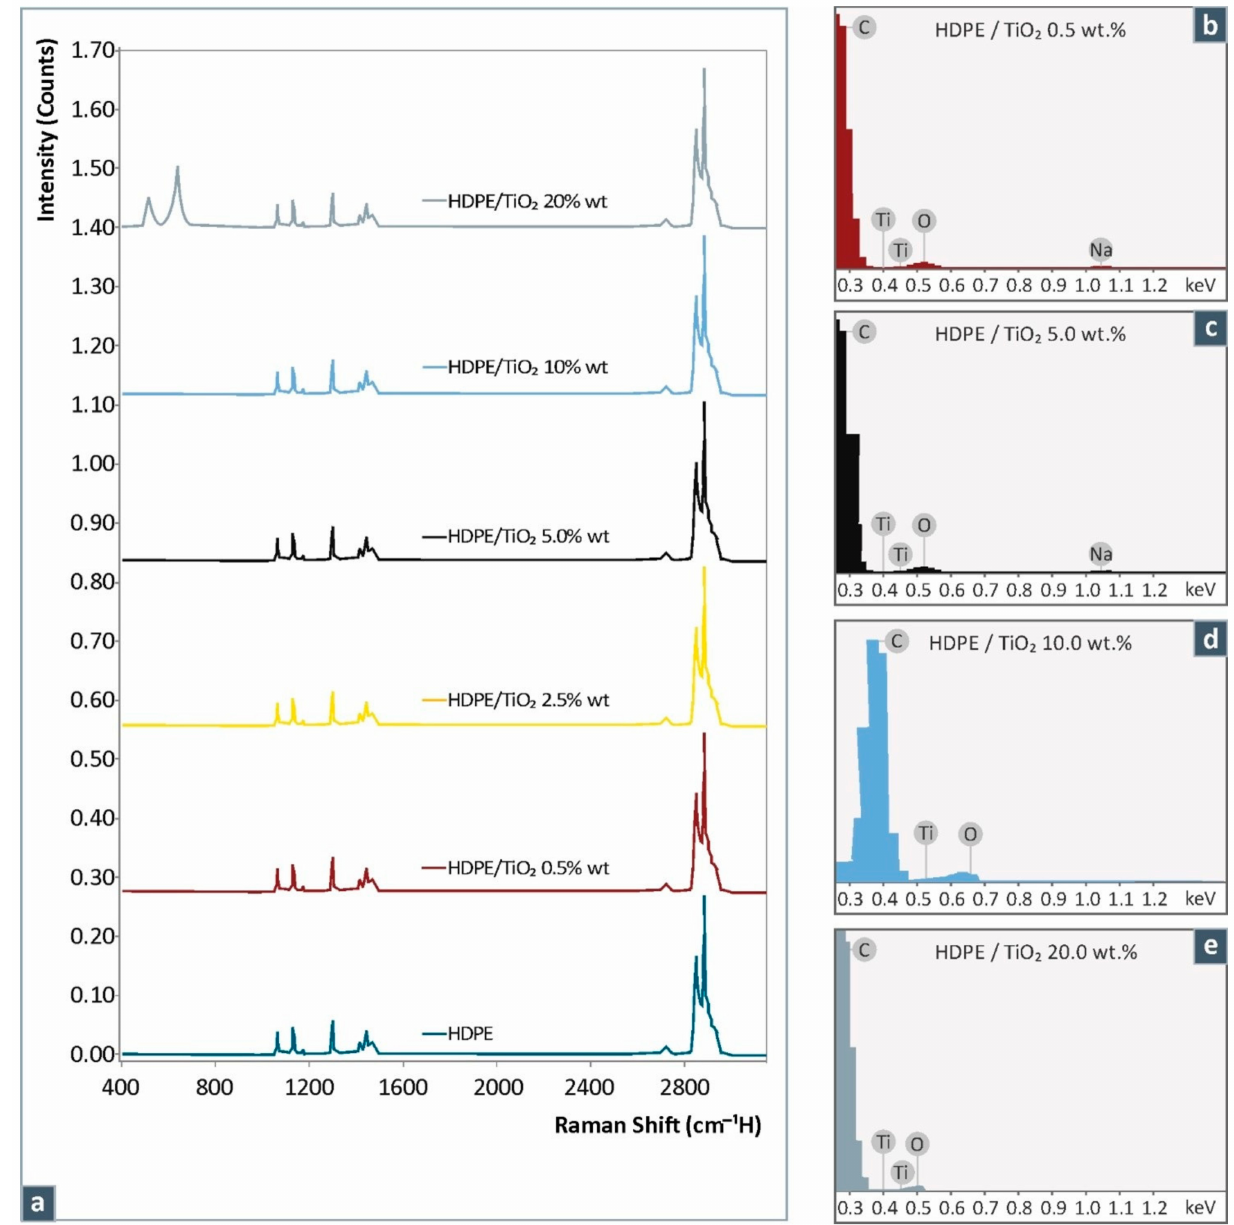
Figure 10. ( a ) Raman Spectra for HDPE with TiO 2 filler and EDS results for filler concentrations ( b ) 0.5, ( c ) 5, ( d ) 10, and ( e ) 20